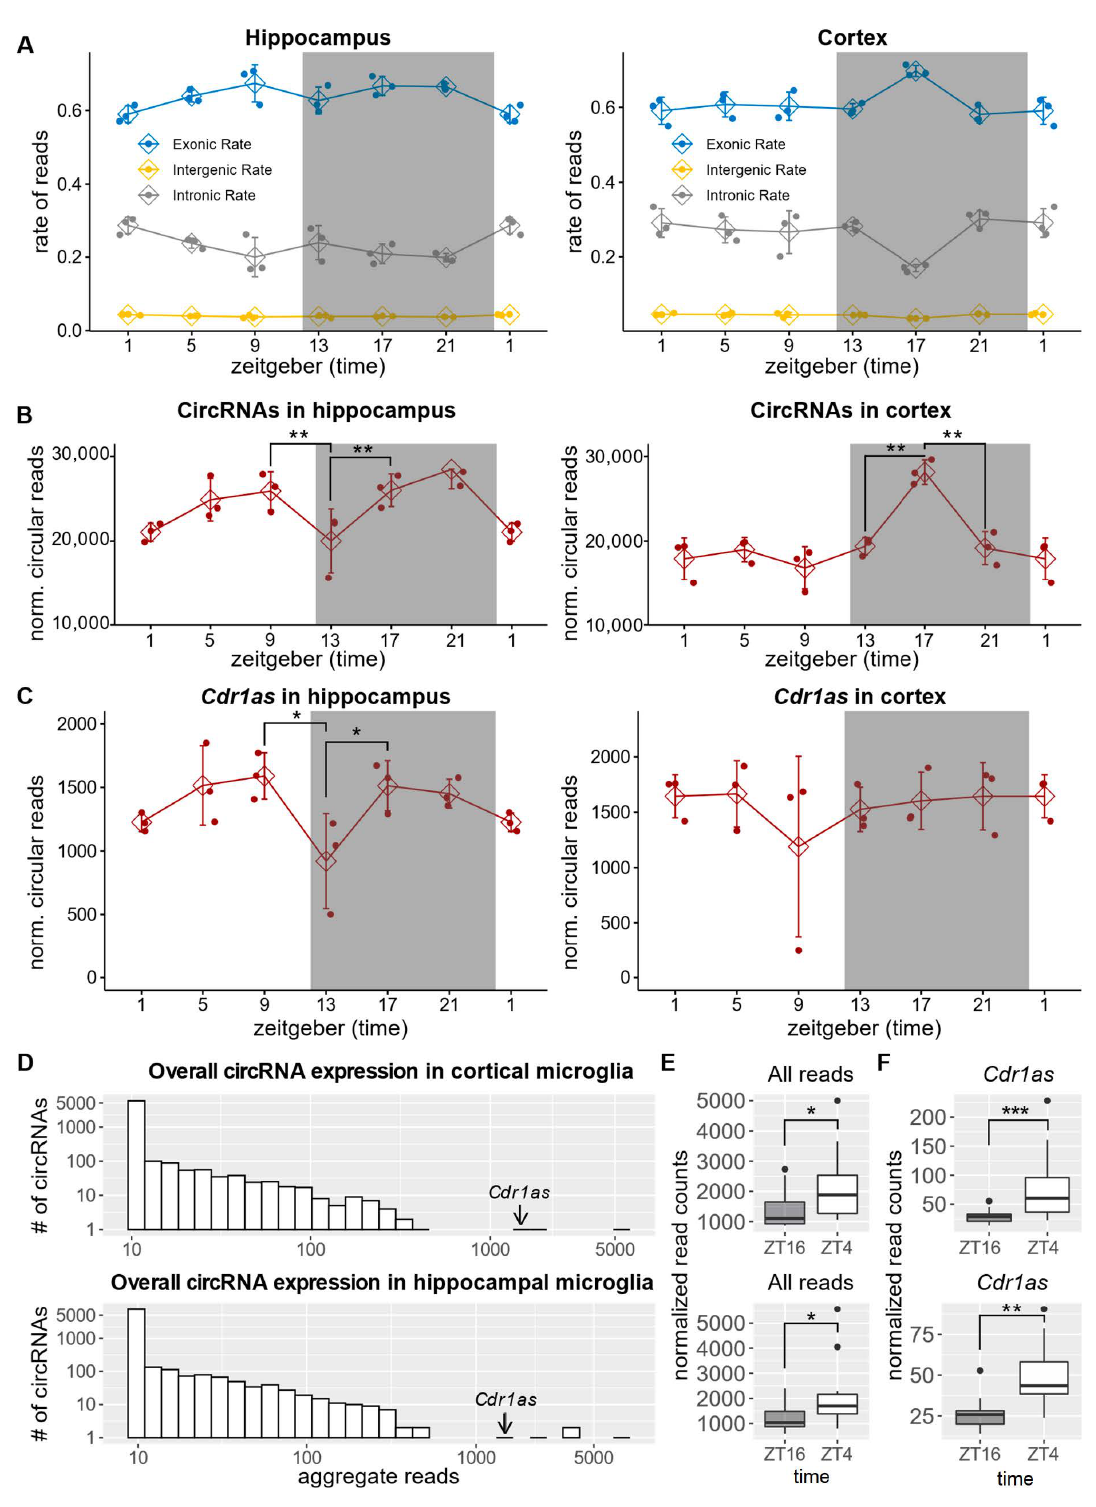
Figure 3. CircRNAs in the hippocampus and frontal cortex. ( A ) Genomic annotation of the sequencing reads. The X-axis is the (zeitgeber) time, and the Y-axis is the fraction of reads. ( B ) Normalized